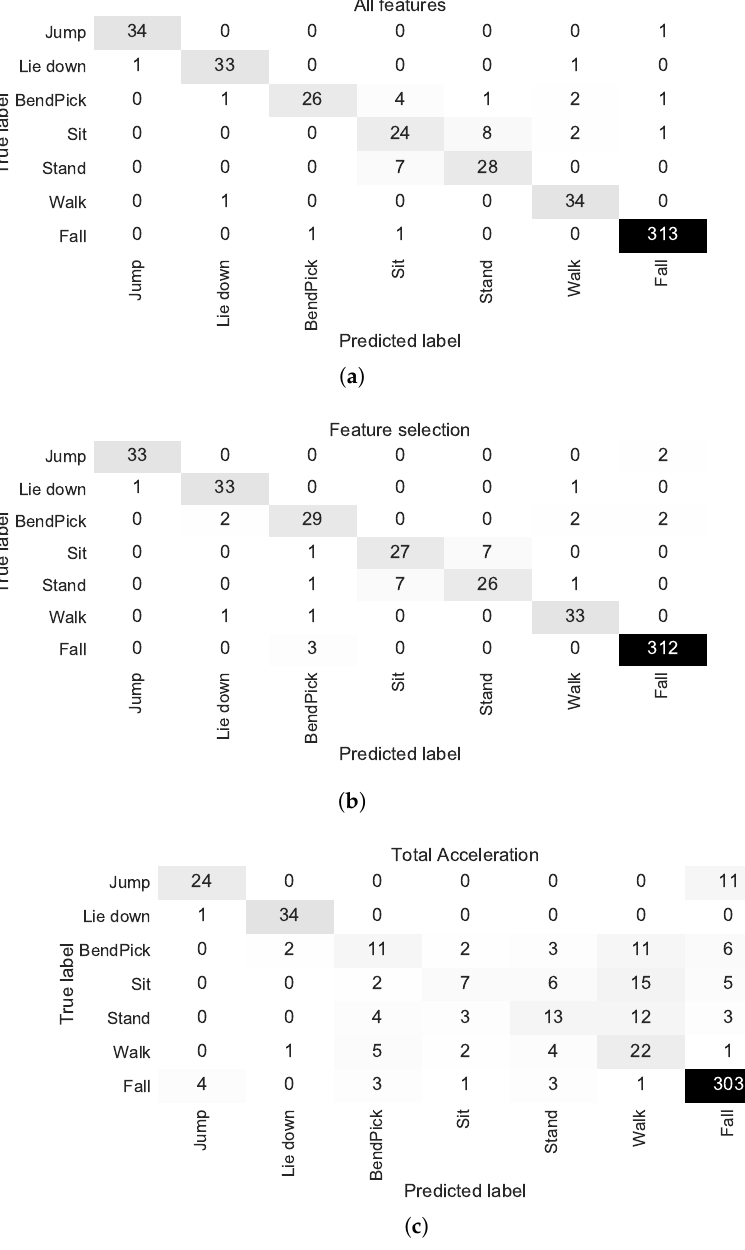
Figure 5. Confusion matrices for the seven-class problem (ADL and Falls) for the best performing classifier using ( a ) all features (LDA), ( b ) feature selection (LSVM-ECOC), and ( c ) the total acceleration features